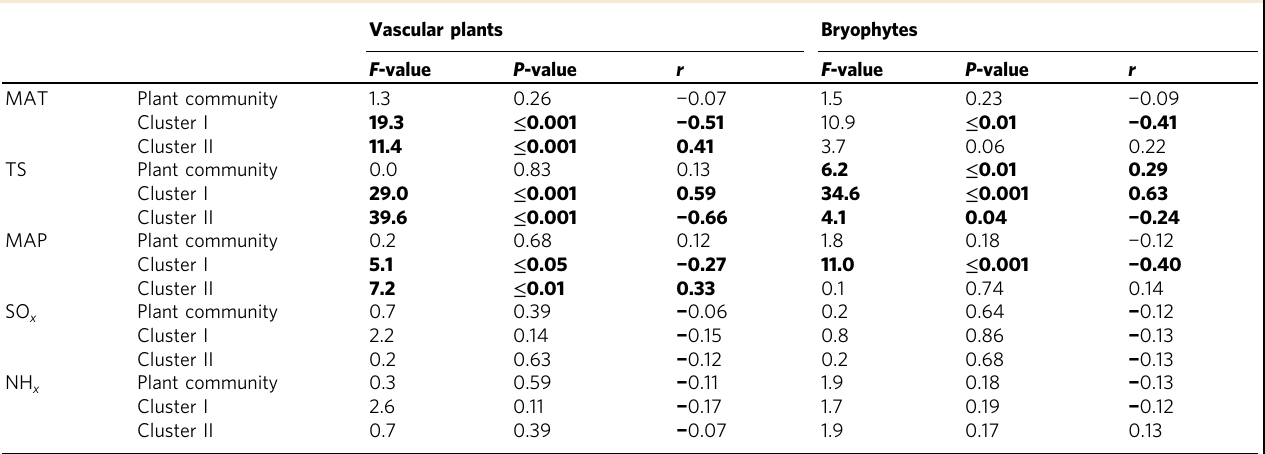
Table 1 Relationships between functional redundancy and environment Vascular plants